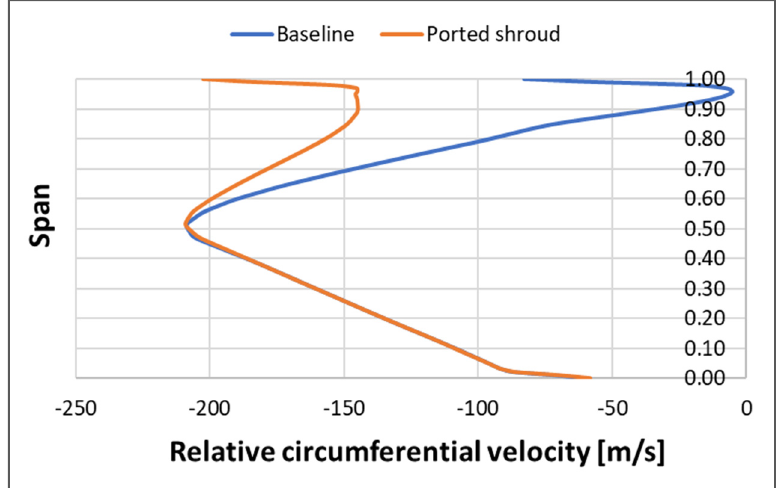
Figure 14. Comparison of the hub-to-shroud distribution of the relative circumferential velocity at the leading edge between the configurations with ported shroud and baseline, at near surge condition OP2.